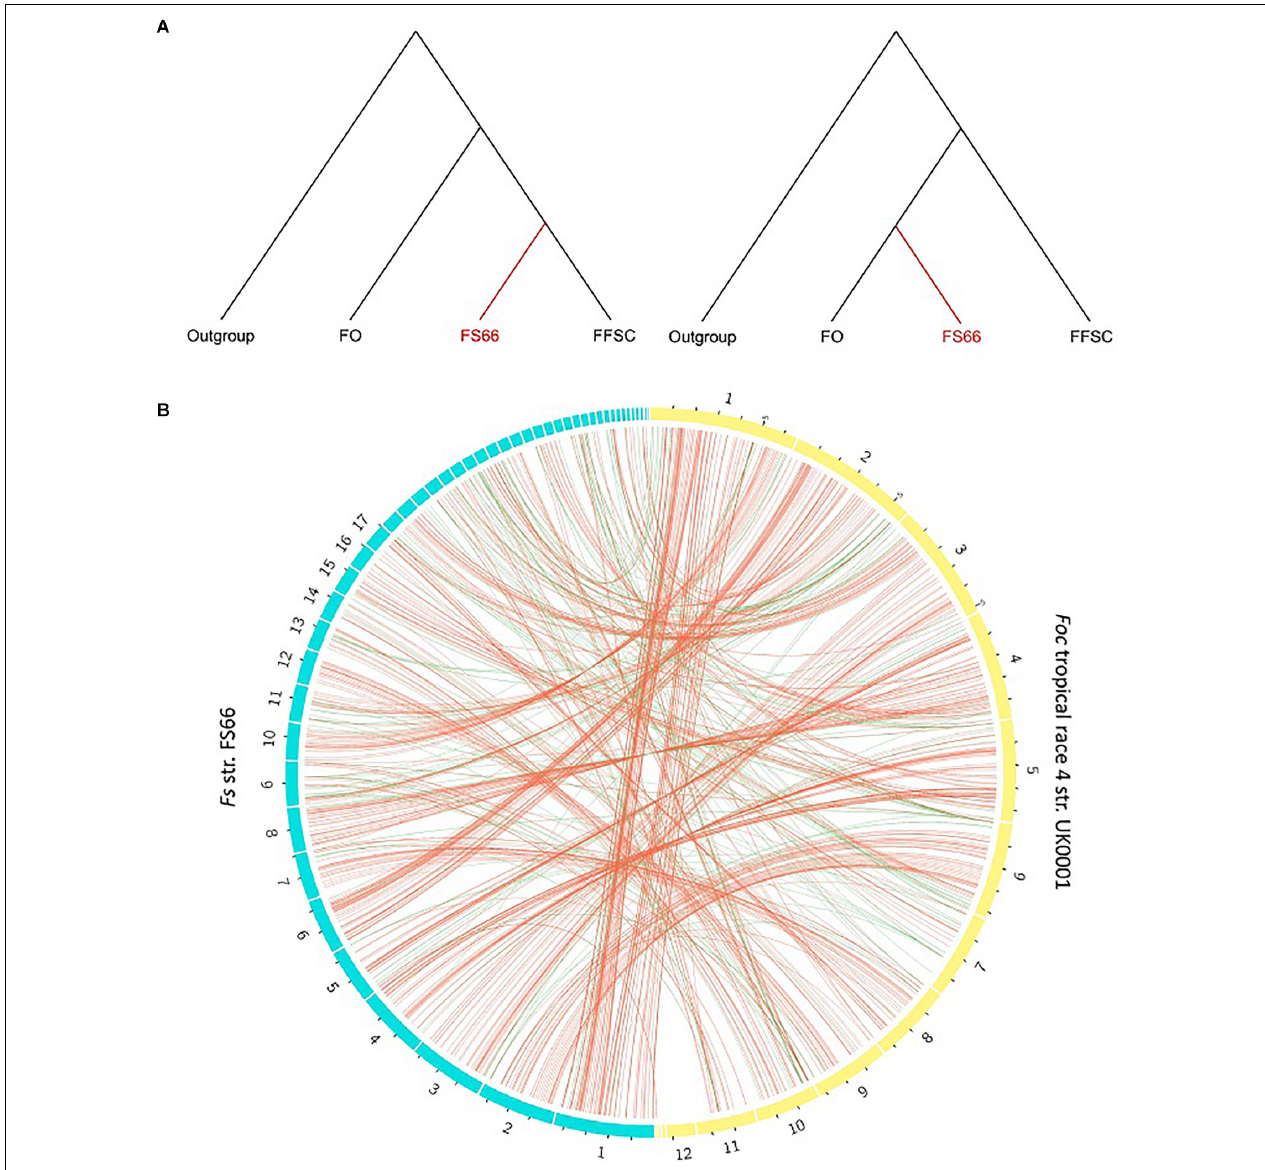
FIGURE 7 | Putative genomic regions transferred from FOSC in the FS66 genome identified by phylogenetic incongruence analysis. (A) S pecies tree (left) and the incongruent molecular tree (right) suggesting gene transfer from FOSC in FS66. (B) Genomic regions putatively transferred from FOSC across the FS66 genome. Red links were inferred by phylogenetic incongruence analysis and green links were inferred based on that they were shared between FS66 and FOSC but not found in other tested FFSC